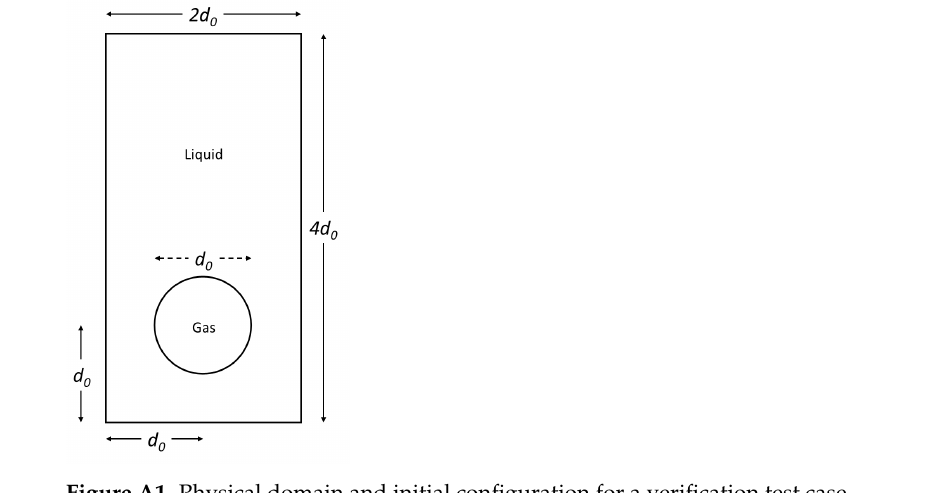
(cid:112) gd 0 , and